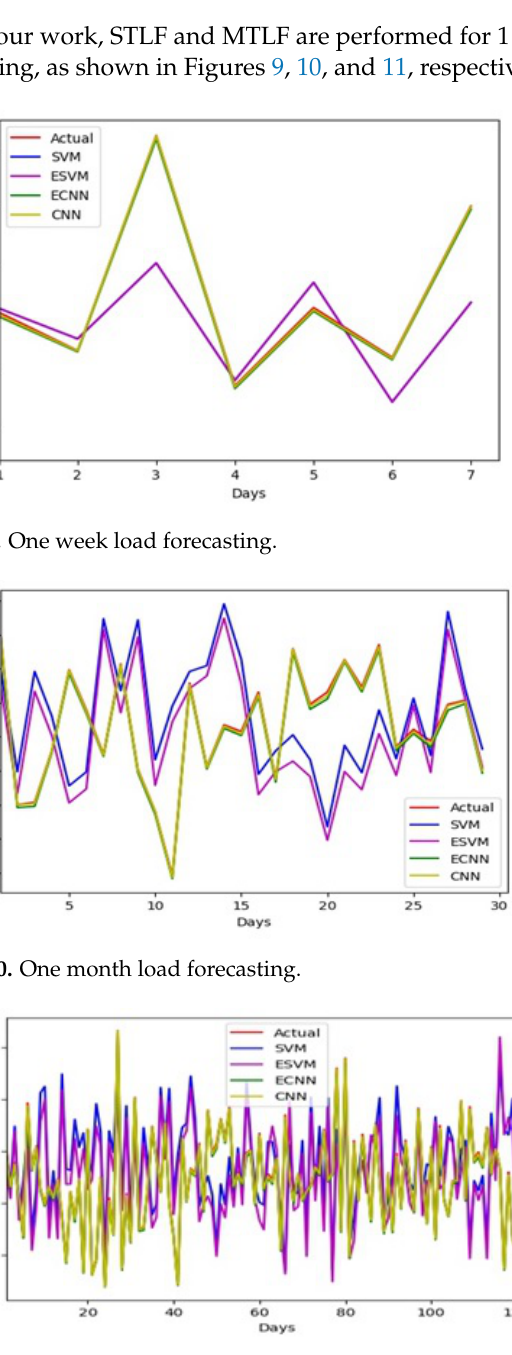
Figure 11. Four months load forecasting. The different colored lines represent these predicted values. The red line represents the actual load. Lines most similar to the actual load represent high accuracy, whereas less- similar lines represent low accuracy. In the above figures, it can be seen that the prediction line of the proposed ECNN technique is more similar to the actual load line. The proposed ESVM has a lower similarity than ECNN. However, there is a big difference between the actual load line and the lines of the conventional